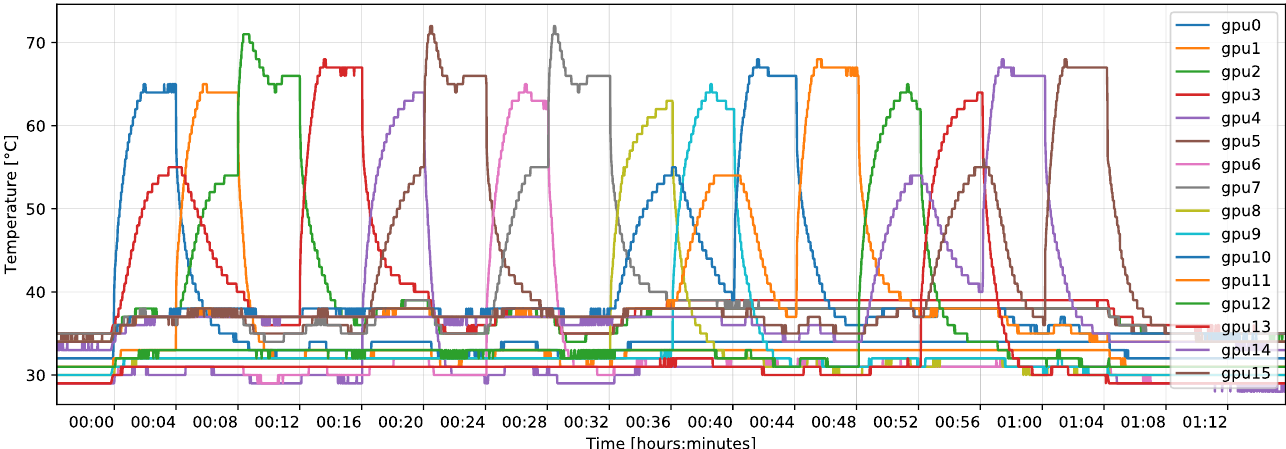
Figure 4. Temperature of the DGX-2 GPUs when fully loaded with Tensor Core benchmark one after another. A GPU in the first row (0, 1, 4, 6, 8, 9, 12, 13) increases also temperature of the GPU located directly behind it in the second row (2, 3, 5, 7, 10, 11, 14, 15).